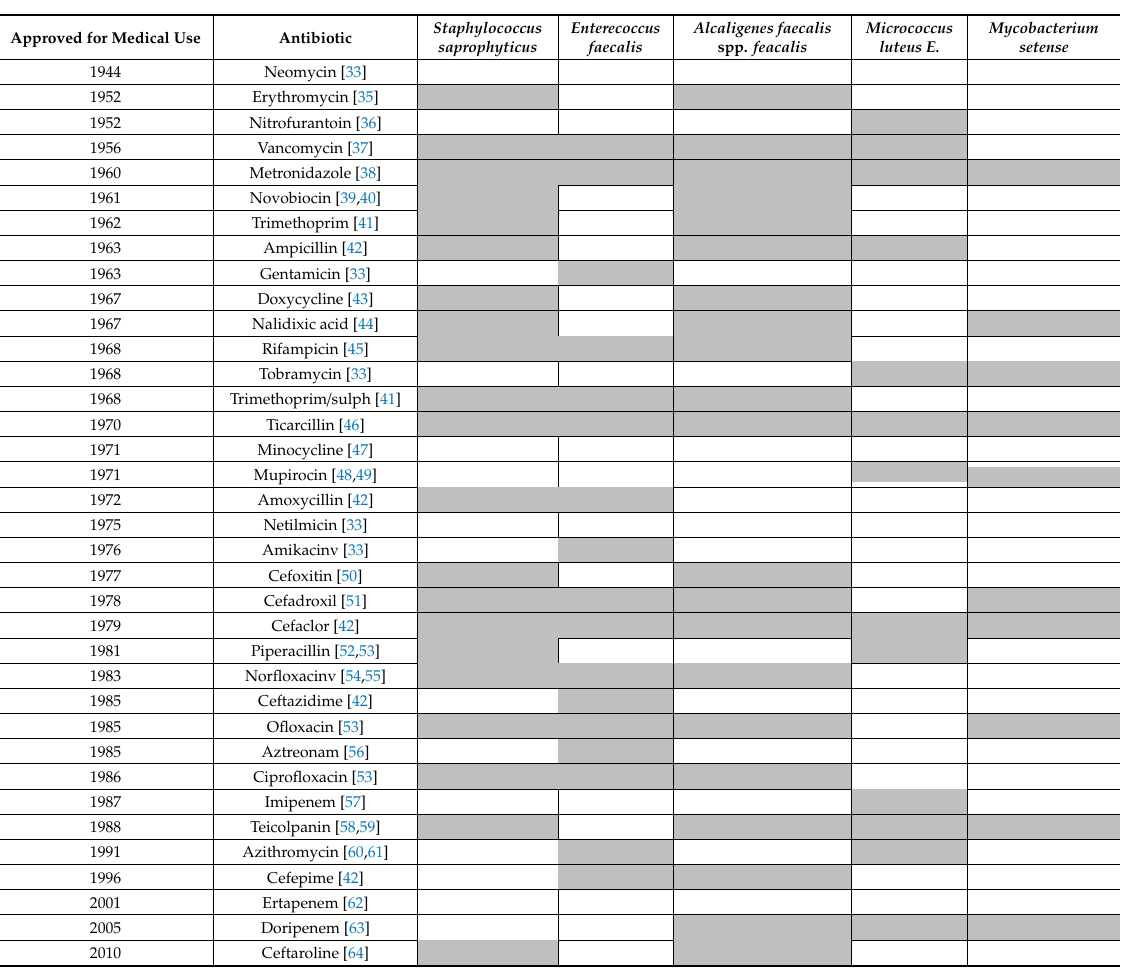
Table 3. The pattern of antibiotic resistance of the isolated strains, including the date of introduction of antibiotics for medical use. Marked boxes indicate